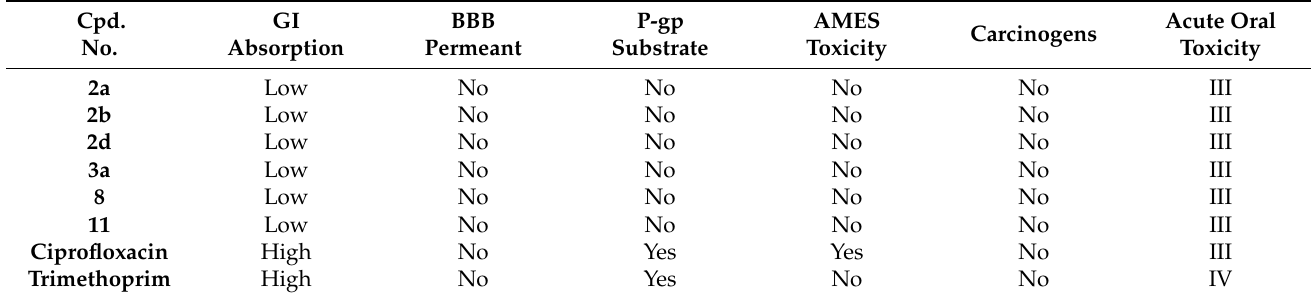
Table 11. In silico some pharmacokinetic properties and toxicity prediction of the most promising sulfaguanidine derivatives as well as standard drugs.